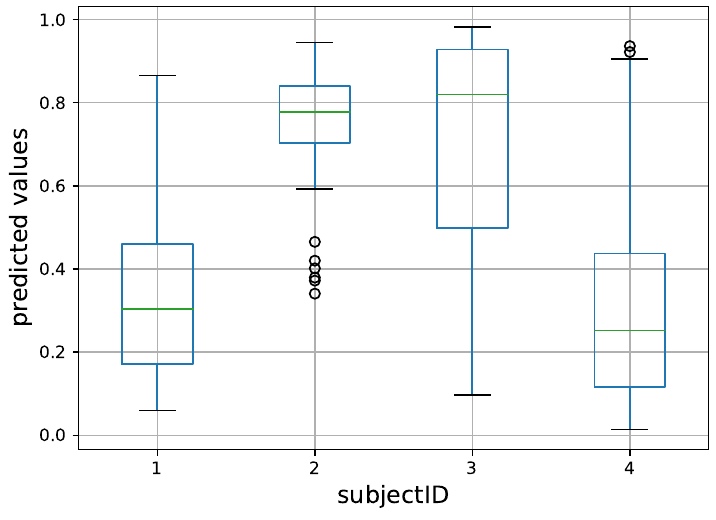
Figure 4. Example boxplots of the normalized predicted values ( ˆ y ) for multiple 10-s sequences, grouped by subject. Subjects 1 and 4 were non-fallers and the other two were fallers. The final prediction per subject was given by the median of the predictions, as per van Schooten et al. [21]. The green line inside the box represents the median, the box represents the range of first and third quartile and circles represent